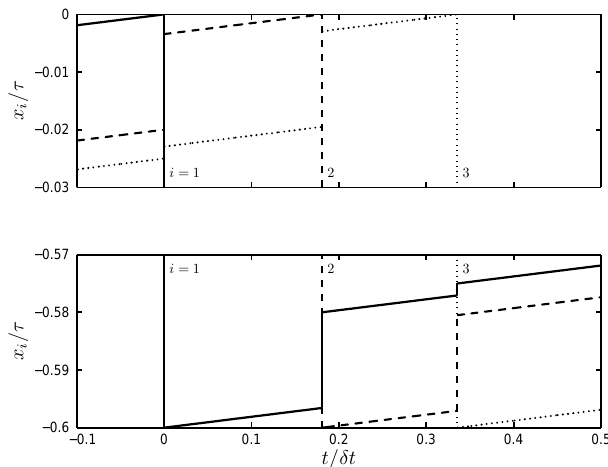
Figure 3. Evolution of a system made up of three faults ( n = 3): components of the state vector x as functions of time during the seismic sequence shown in Fig. 2 ( τ = 1MPa, δt = 1a). The steps labelled by i = 1, 2 and 3 correspond to the occurrence of the events in the sequence.